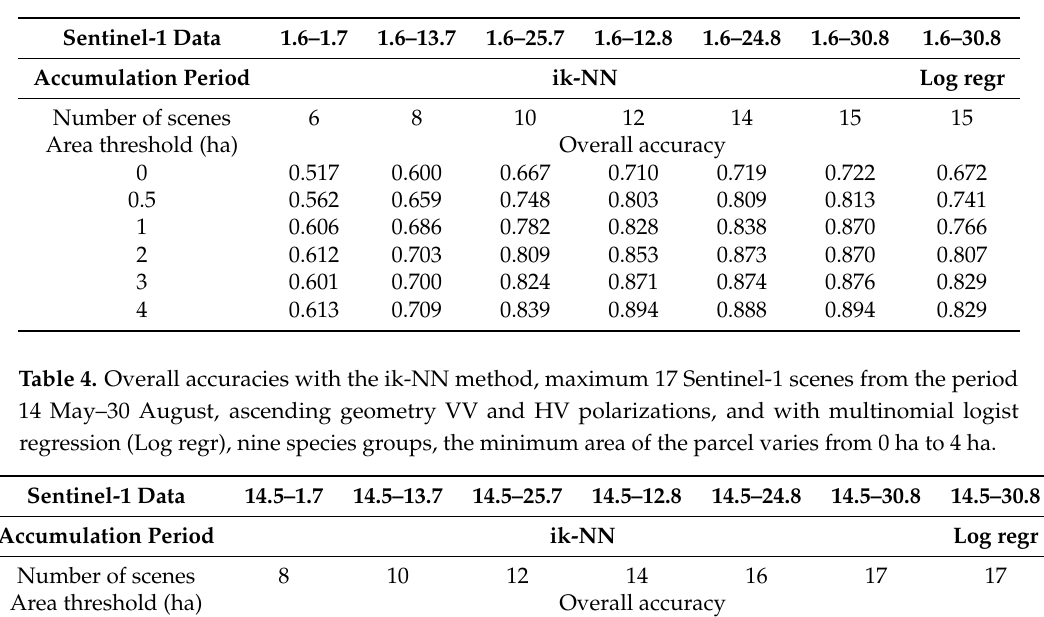
Table 3. Overall accuracies with the improved k nearest neigbor (ik-NN) method, maximum 15 Sentinel-1 scenes from the period 1 June–30 August, ascending geometry VV and HV polarizations, and, with multinomial logist regression (Log regr), nine species groups, the minimum area of the parcel varies from 0 ha to 4 ha.